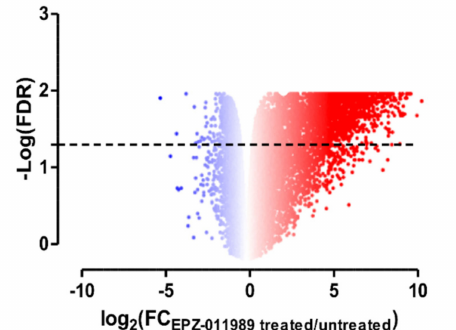
Figure 3. EZH2 inhibition leads to significant gene expression changes in ES-1 PDX. Volcano plot of genes di ff erentially expressed between untreated and EPZ-011989-treated tumor samples; the red–blue colormap is used as a graphical visualization of the magnitude of log2 fold change (FC) representing the positive and negative values, respectively.